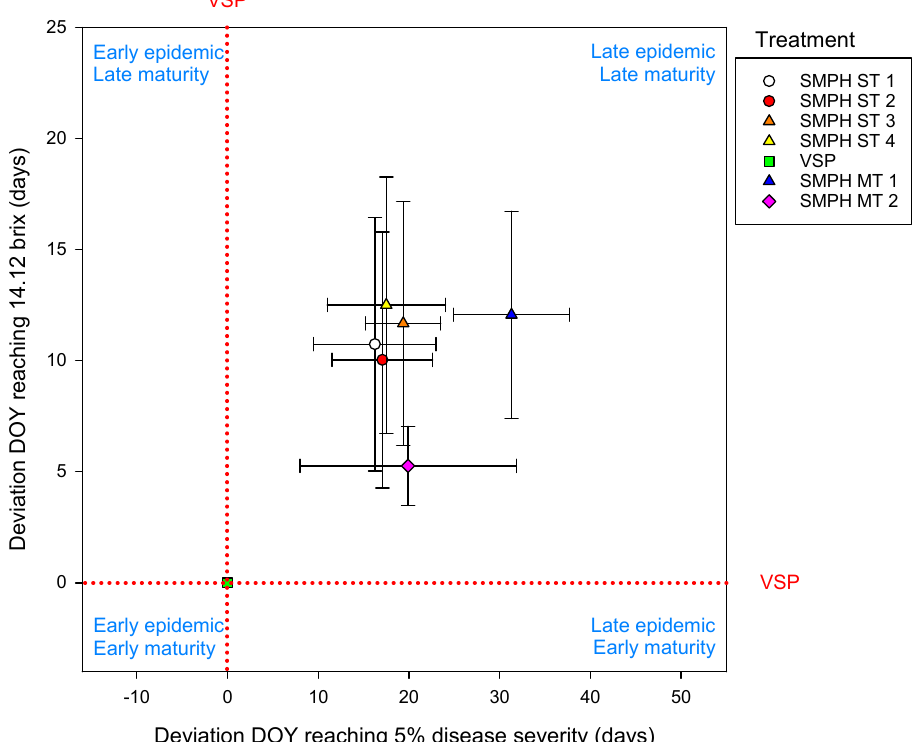
Figure 5. Temporal deviations of the day of the year (DOY) for reaching 5% disease severity in the different treatments compared to the standard treatment, VSP, plotted against the temporal deviations of the day of the year (DOY) for reaching 14.12 brix in the different treatments compared to VSP. Data from 2014 to 2017. Error bars = standard errors.